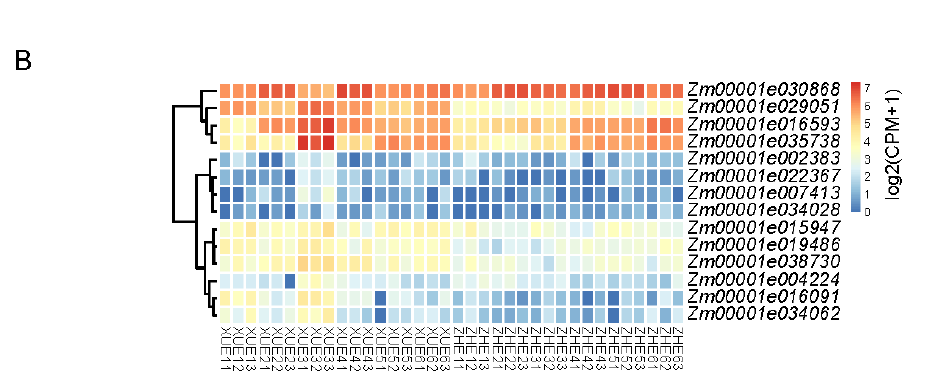
Figure 7. KEGG enrichment of MEyellow module genes ( A ) and heatmap of each sample expression level of starch and sucrose metabolism genes ( B ).